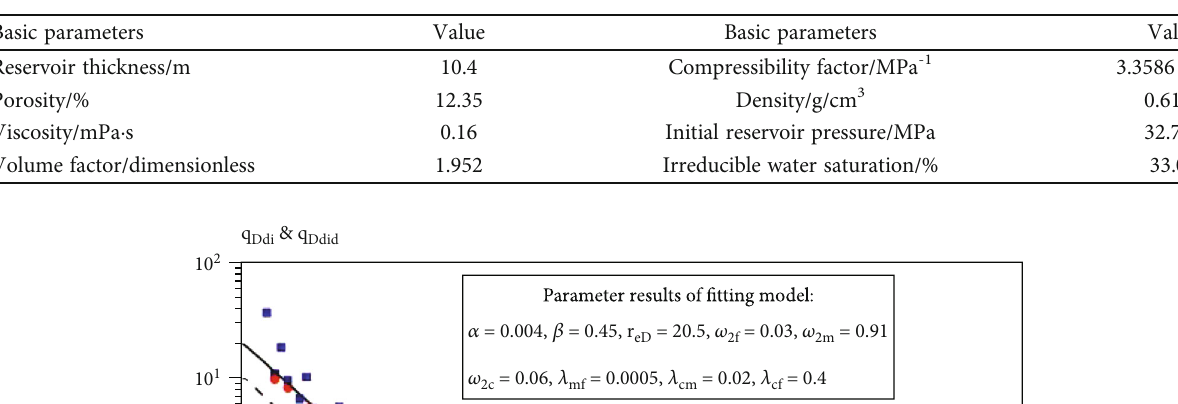
Table 3: Basic parameters of CT-2 in North Truva Oil fi eld.